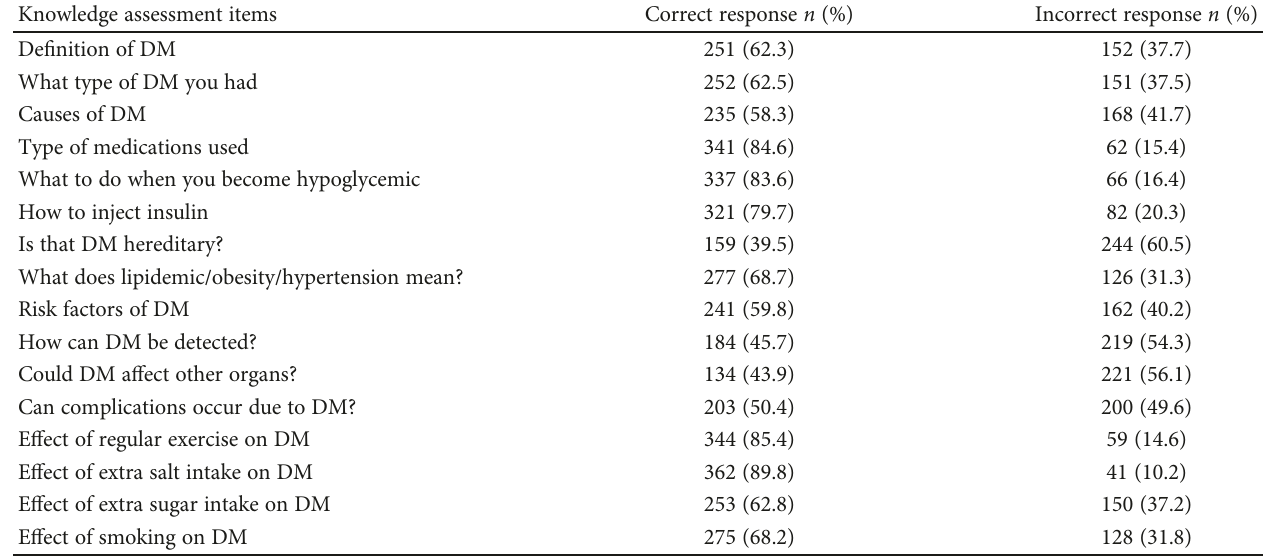
Table 2: Knowledge assessment towards glycemic controls among DM patients at the University of Gondar referral hospital 2018.